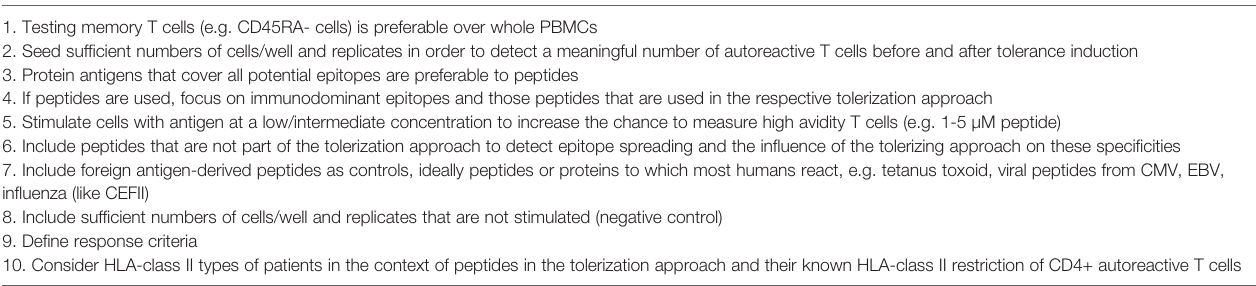
TABLE 2 | Important considerations for measuring the frequency of autoantigen-speci fi c CD4+ T cells. 1. Testing memory T cells (e.g. CD45RA- cells) is preferable over whole PBMCs 2. Seed suf fi cient numbers of cells/well and replicates in order to detect a meaningful number of autoreactive T cells before and after tolerance